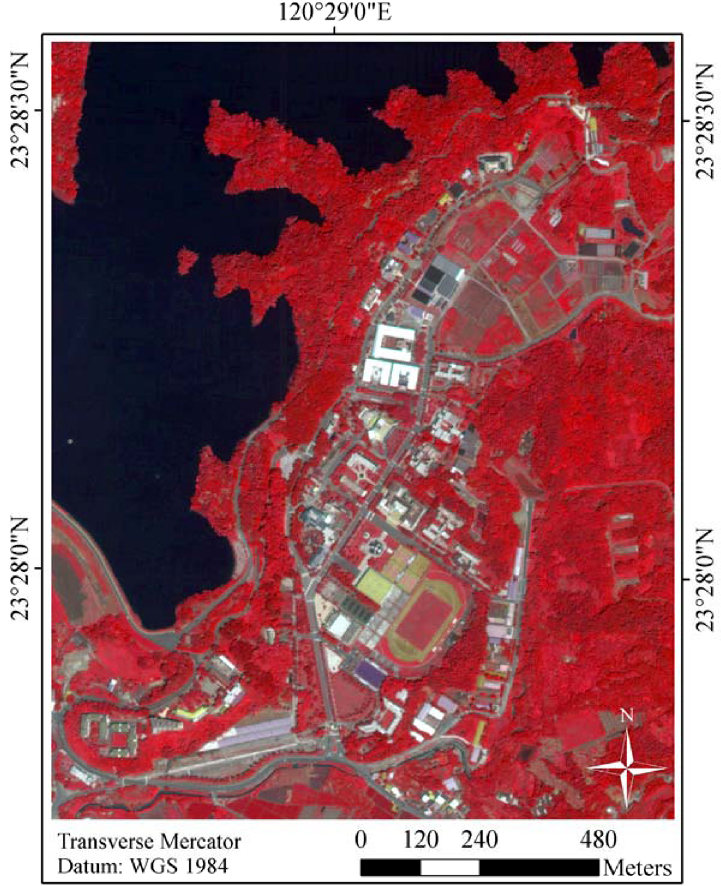
Fig 1. A false color picture of the QuickBird multispectral image (a composite of band 4, 3, 2 for red, green, and blue) showing the land covers over the study